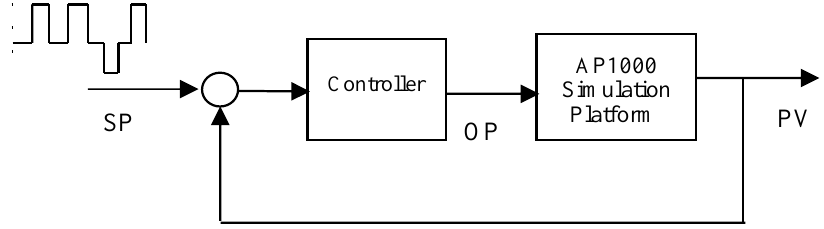
Figure 10. Diagram of closed-loop test for AP1000 SG.